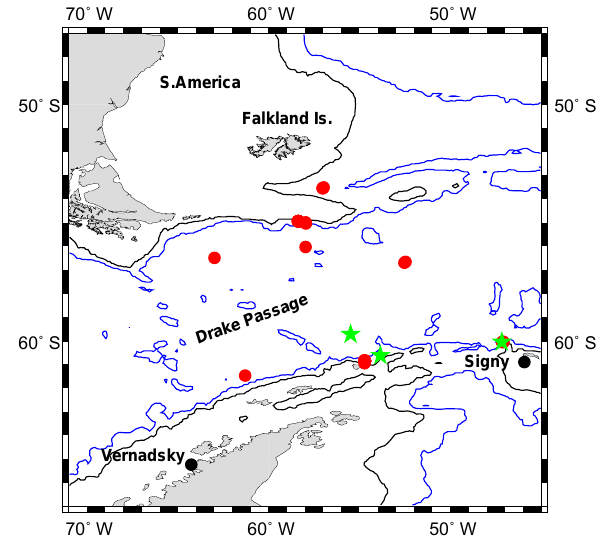
Figure 2. Map of the Drake Passage showing the locations of the 45 BPR deployments and the Vernadsky (Faraday) Research Base. Red dots indicate deployments by bottom landers based on the “Mk.IV” design, while green stars indicate deployments by MYR- TLE instruments. Depths of 1000 and 3000m are shown by the black and blue contours,